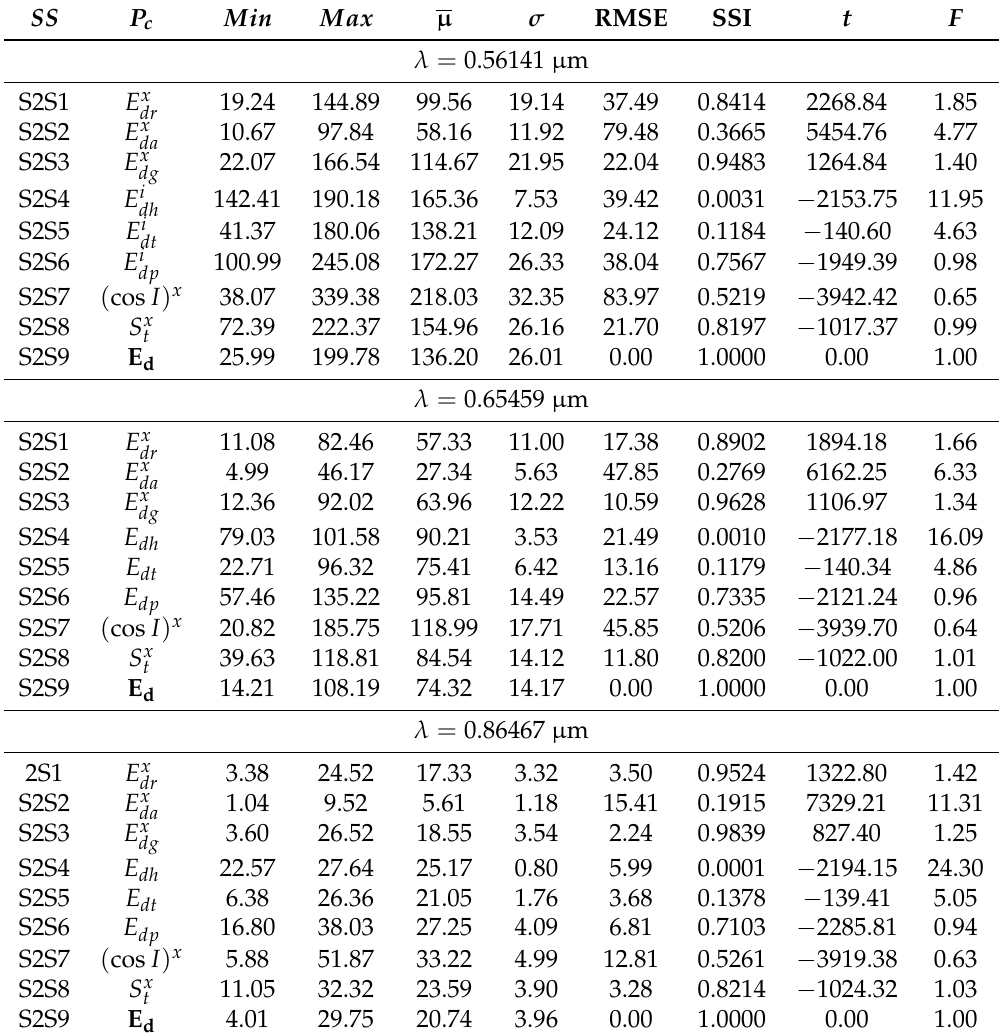
( F ). Control parameters symbols are defined in the methodology and symbol notation table in Appendix A (Tables 3 and A1). All inferential tests using the t -statistic and F -ratio were significant at the p = 0.0001 level for all regions of the spectrum, indicating that the magnitude and variance structure of diffuse irradiance is significantly different when parameters characterizing topographic effects are not accounted for, or when a different parameterization scheme is